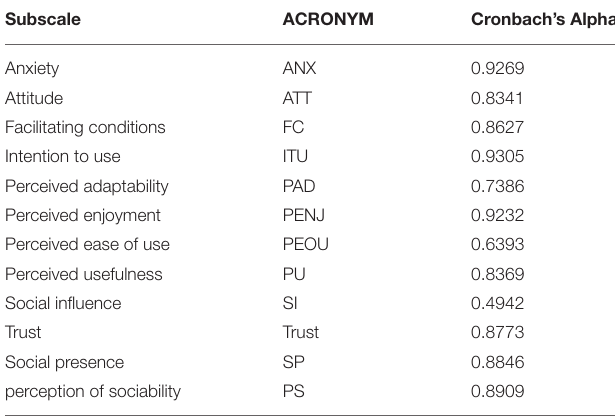
TABLE 4 | The Cronbach’s alpha values of the Unified Theory of Acceptance and Use of Technology (UTAUT). Subscale